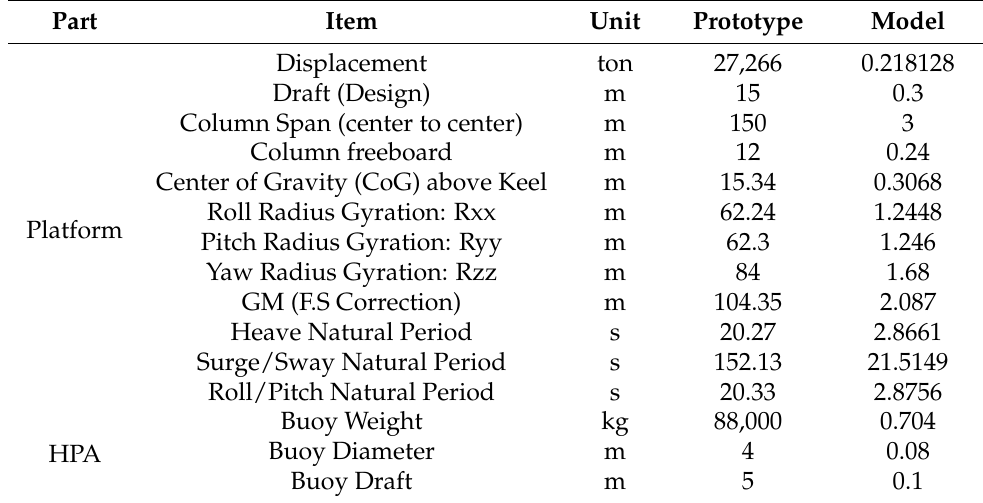
Table 3. Specifications of multiple HPAs and large semi-submersible (scale 1:50). Part